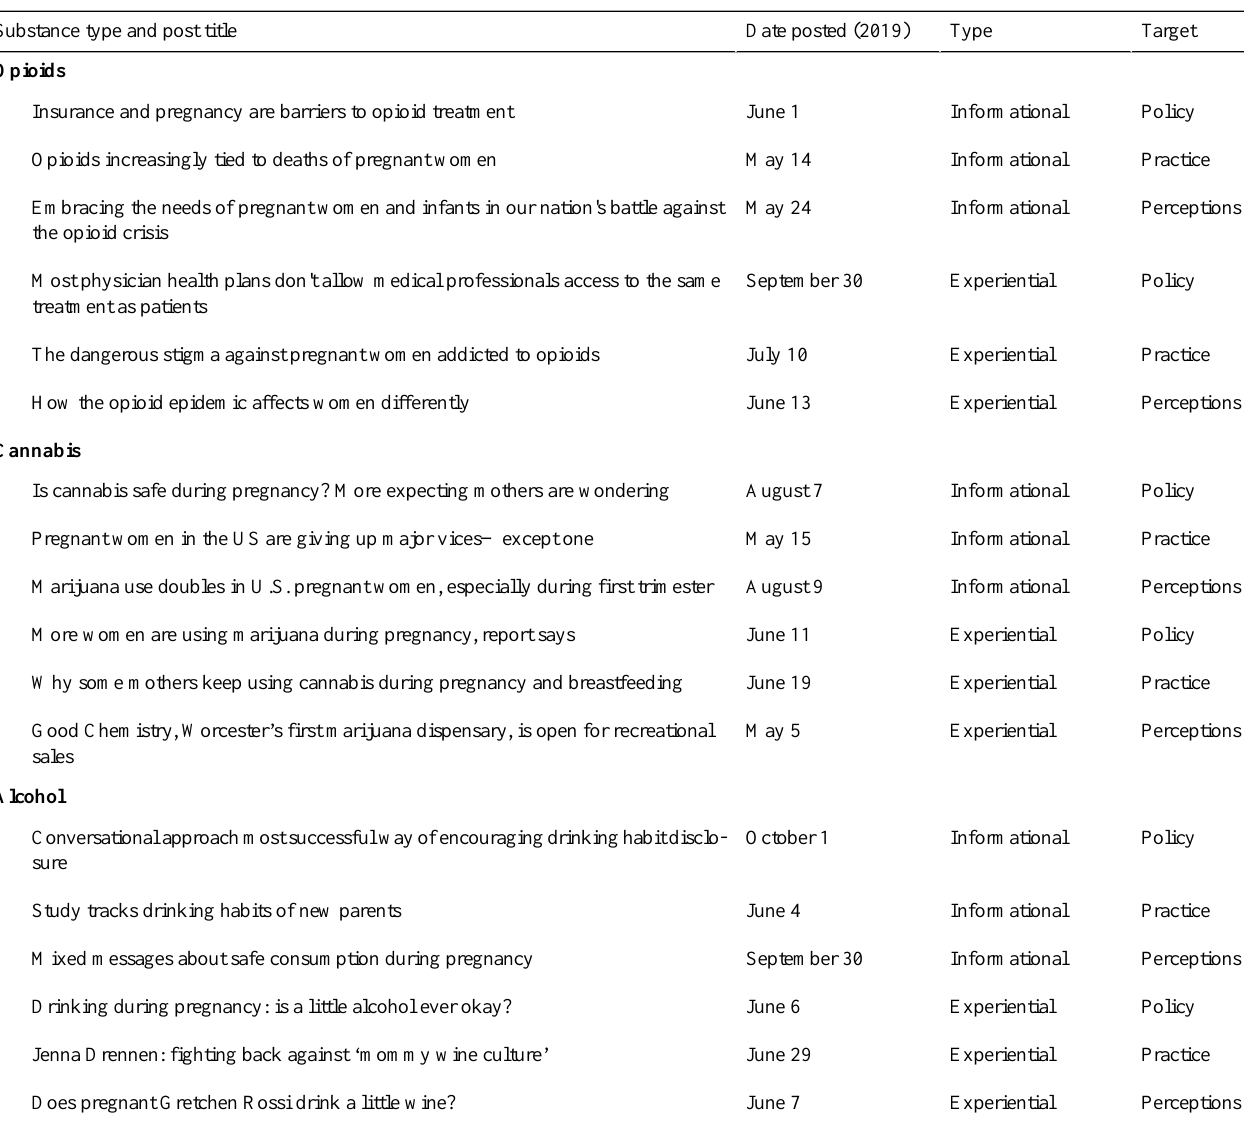
Table 1. Characteristics of Facebook posts classified by